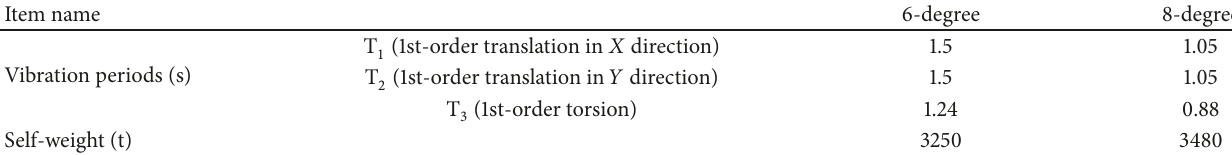
Table 2: Dynamic properties of the